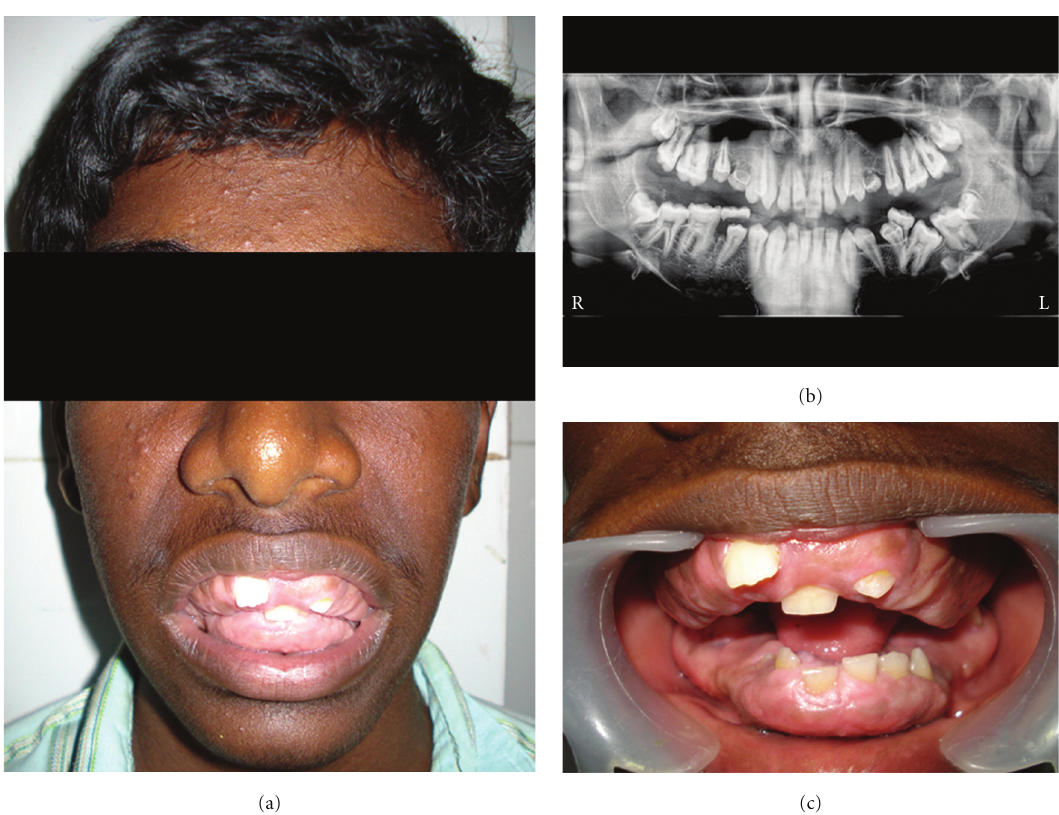
Figure 1: (a) Showing patients photograph. (b) OPG. (c) Intraoral front view.